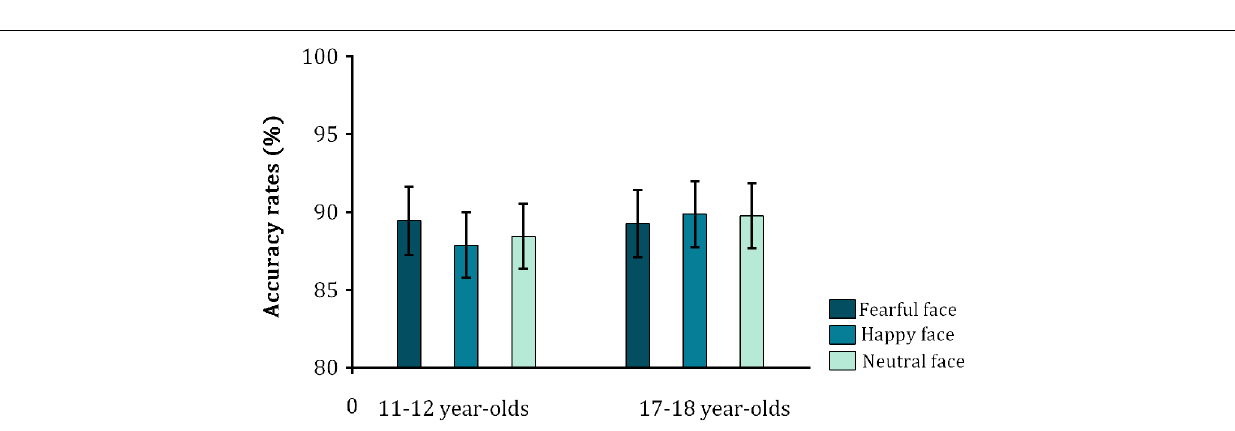
( Figure 4 ) established that the simple main effect of emotional expression was not significant in either age group [Younger group: [ F ( 2 , 56 ) = 1 . 06, p = 0 . 057, η p 2 = 0 . 047]; Older